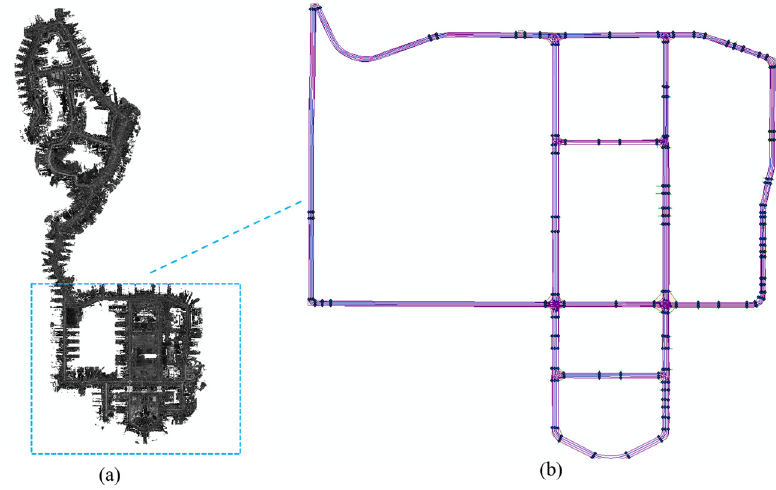
Figure 13. The experimental environment in this paper ( a , b ). Table 4. The main driving parameters of the road. Item